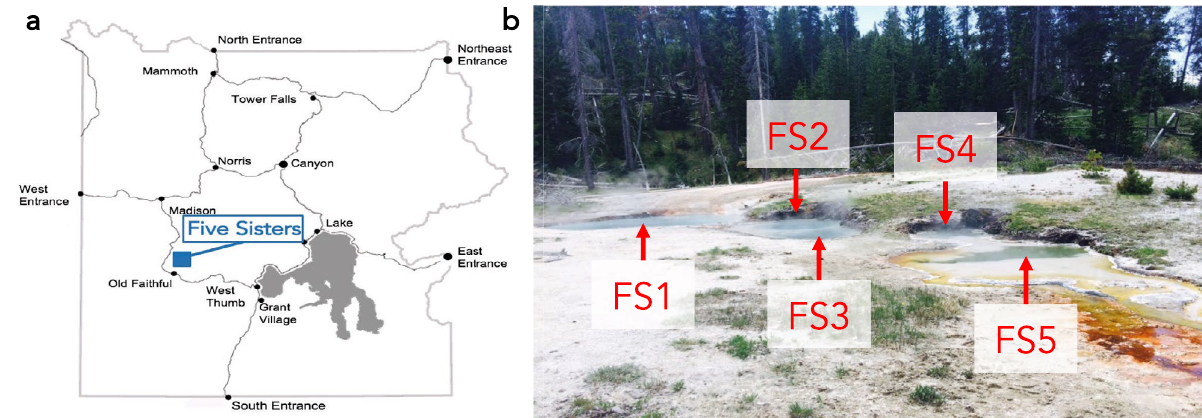
Figure 1. Sampling occurred at the Five Sisters spring system in the White Creek Drainage in YNP. ( a ) Map of YNP indicating the location of the Five Sisters springs north of Old Faithful generated using Adobe Illustrator vCC, adobe.com . ( b ) Picture of the Five Sisters springs with all five pools